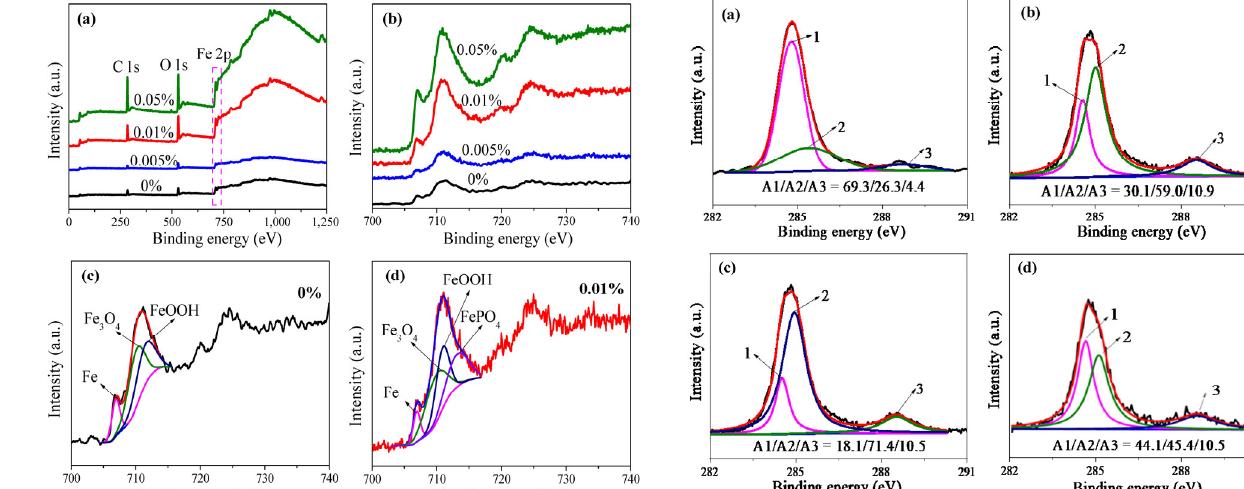
| https://mc03.manuscriptcentral.com/friction